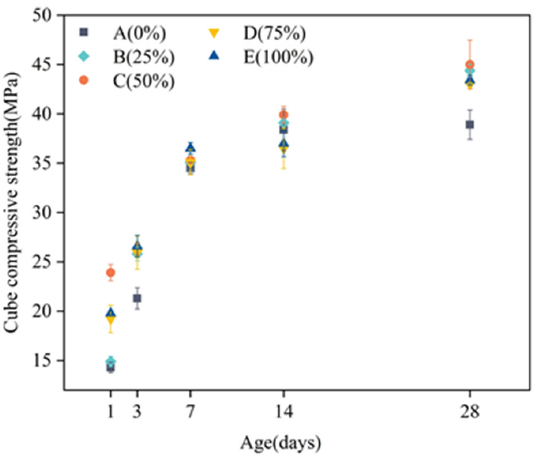
Figure 5. Relationship diagram of the compressive strength of concrete cubes at different